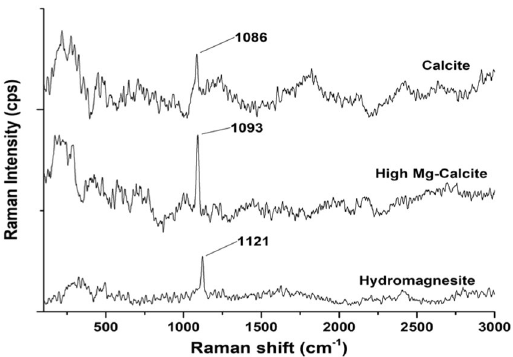
Figure 4. Raman spectra of different types of crystal formed in Virgibacillus culture experiments compared to that of calcite, dolomite, and hydromagnesite